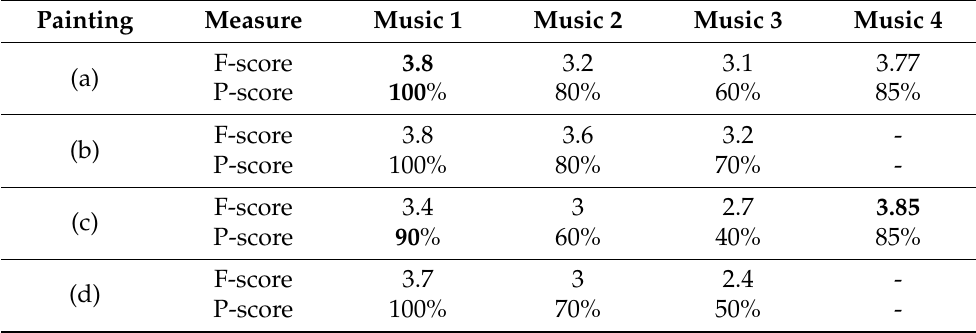
Table 6. Results of the subjective fitness experiment. The F-score is the fitness score and the P-score is the preference ratio. Fitness was measured on a five-point Likert scale, whereas the P-score reflects the proportion of individuals with three or more